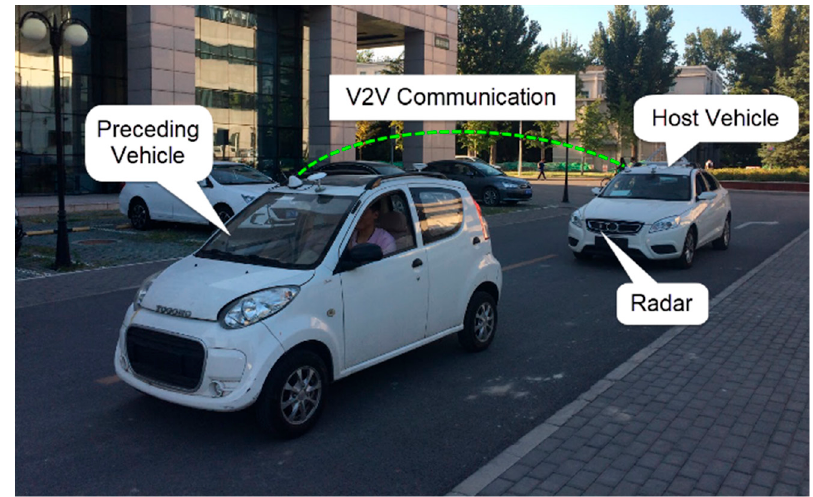
Figure 9. Vehicle-following test scenario.